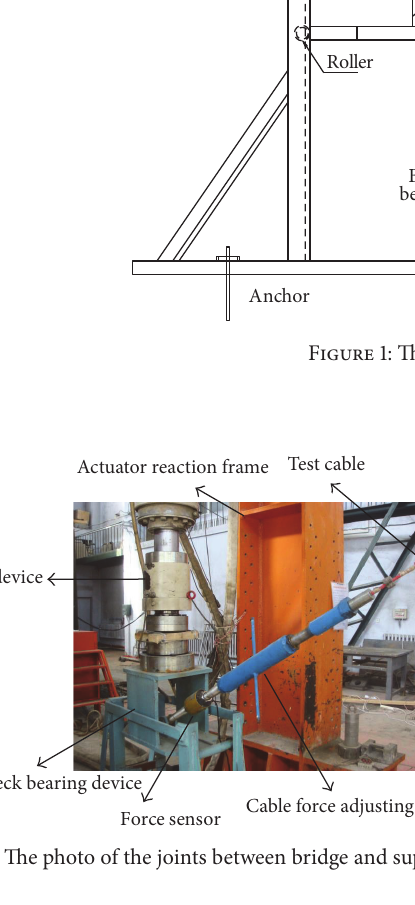
Figure 3: The photo of the joints between bridge and tower.